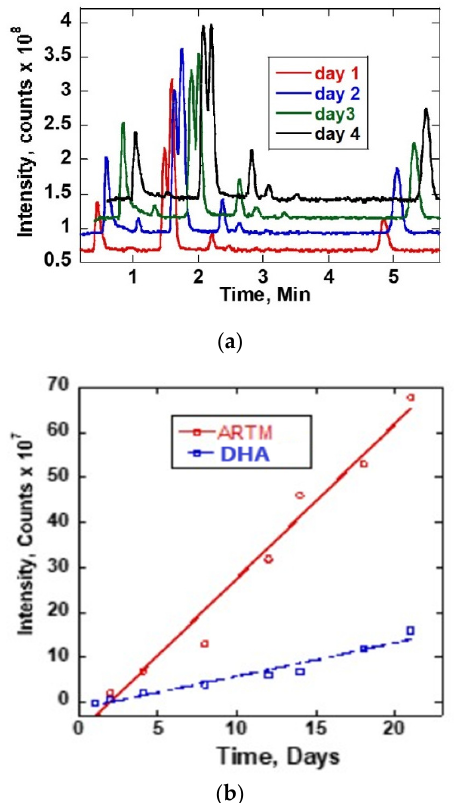
Figure 2. ( a ) TIC chromatograms of ARTS in methanol for different time durations and at 37 °C. ( b ) Plot of intensity as a function of time of DHA and ARTM reaction peaks.